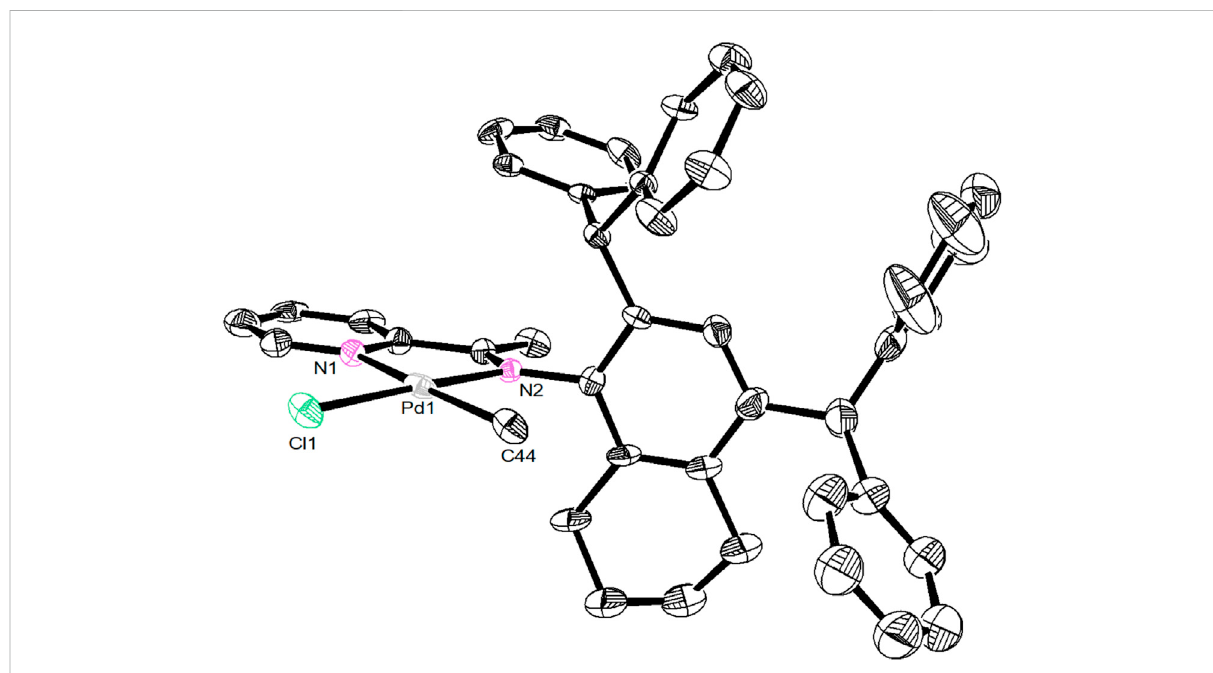
FIGURE 1 Aviewofthesolid-statemolecularstructureof Pd2 (2164023).Ellipsoidsaredrawnatthe30%probabilitylevelandhydrogenatomsareomitted for clarity.